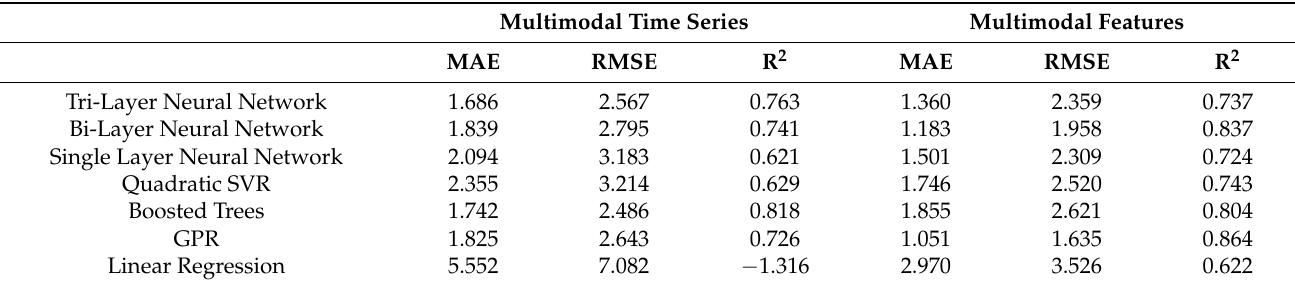
Table 2. ML prediction performance using multimodal time series and features for p -Coumaric